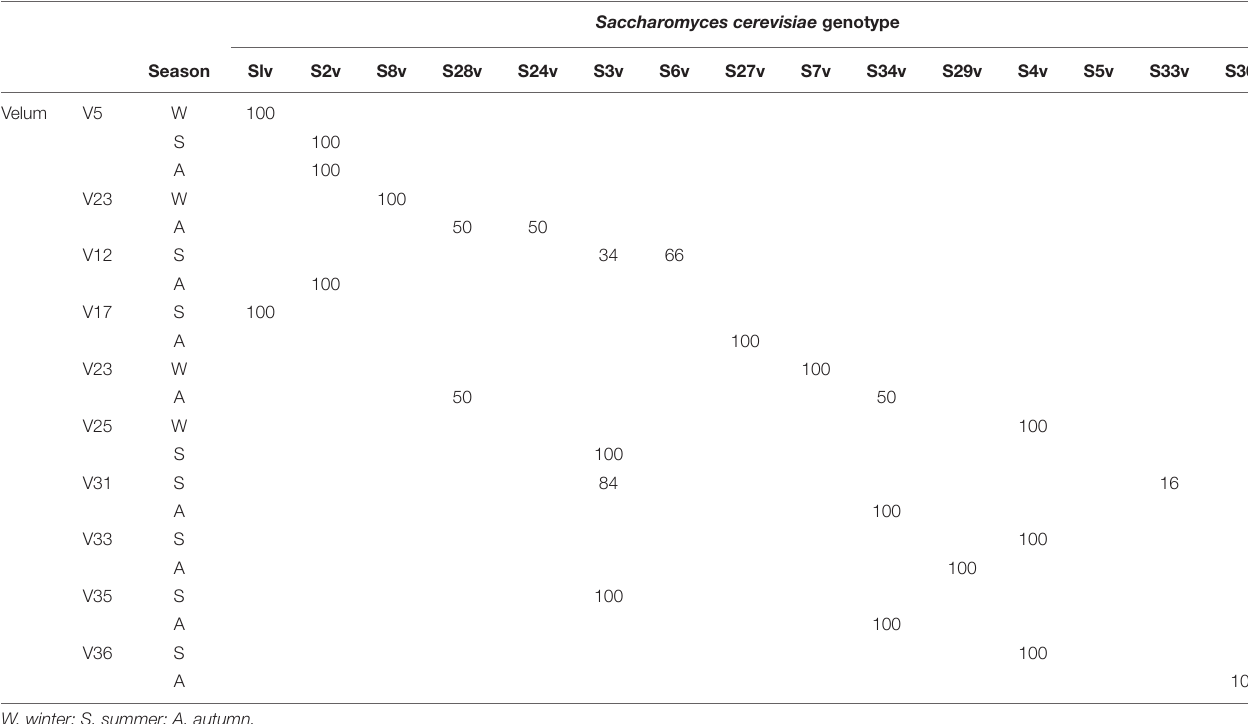
TABLE 4 | Example of the distribution (%) of different Saccharomyces cerevisiae genotypes present in velum (V) showing the shift from one strain to another according to the season.